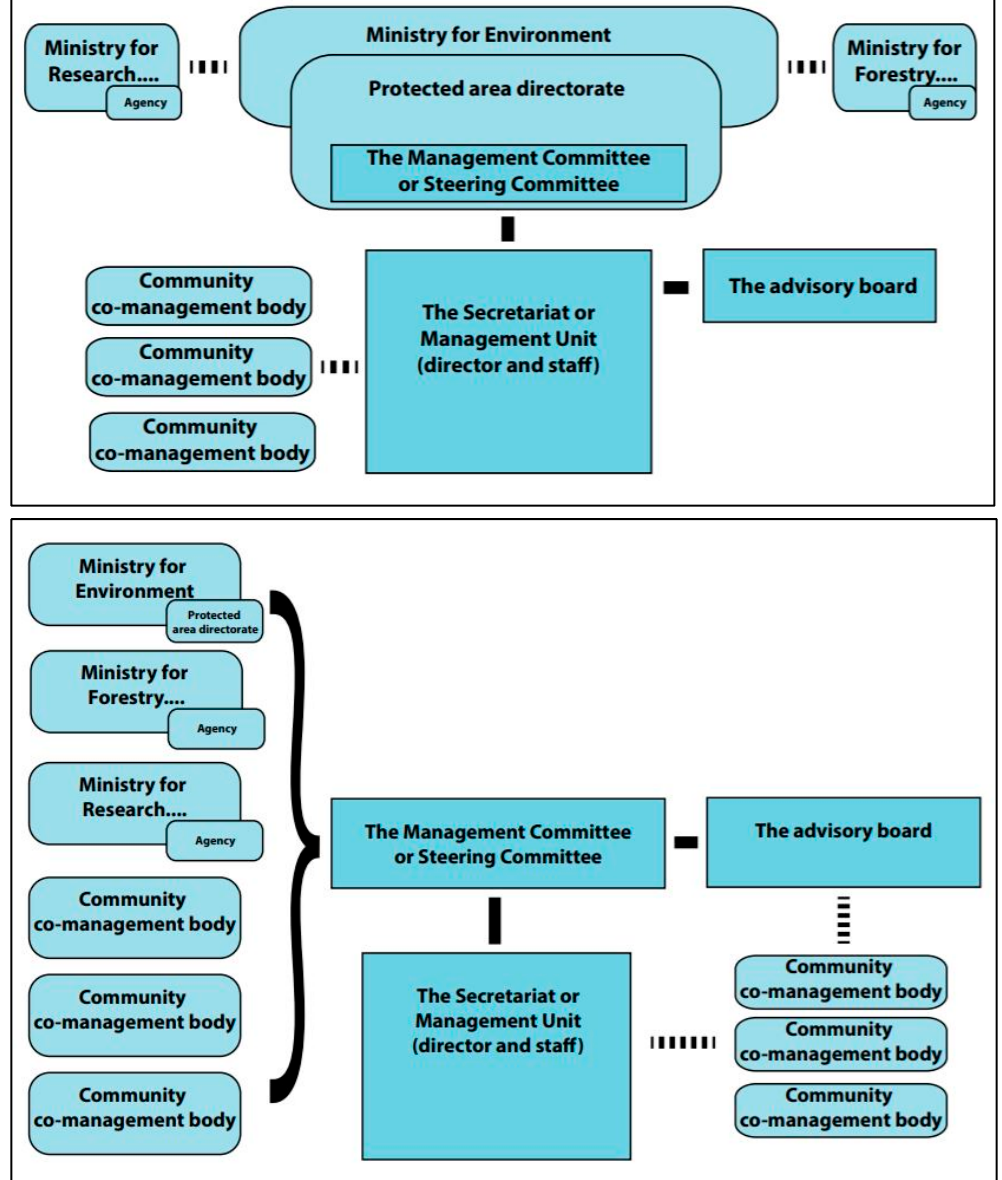
Figure 3. Two exemplary governance models for biosphere reserves: the authority model (above); NGO model (below). Source: [55].